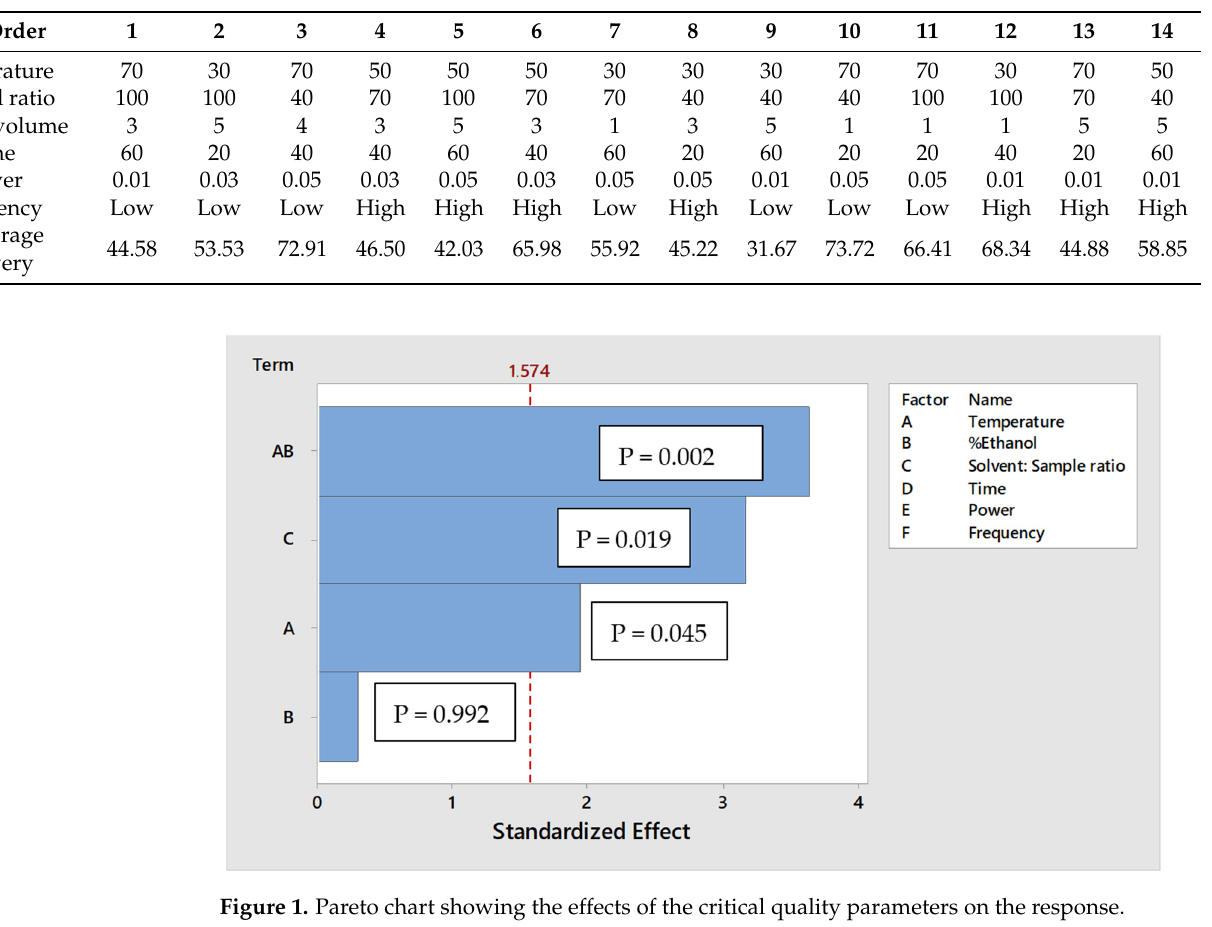
Table 1. Descriptive screening design experiments and the response.